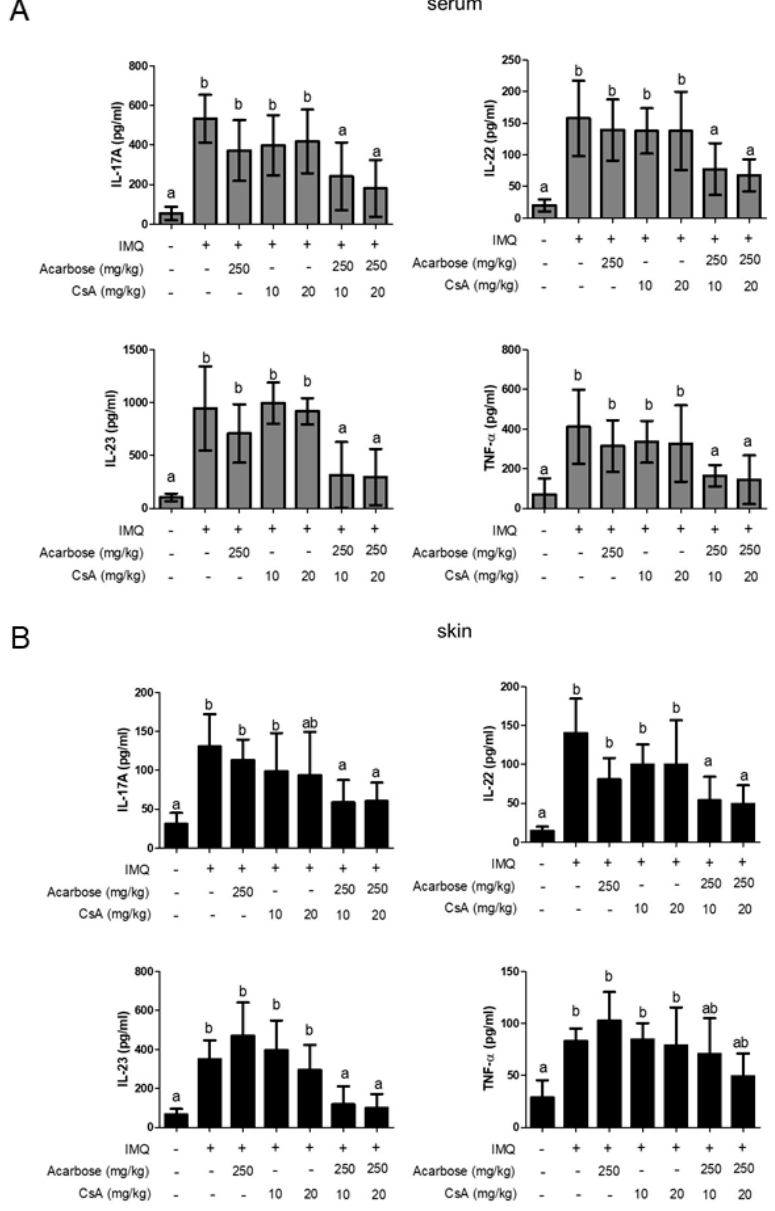
Figure 4. Effect of Acar (250 mg/kg) and/or low-dose CsA (10 or 20 mg/kg) on serum and skin cytokines in mice with IMQ-induced psoriasis-like dermatitis on a daily basis for 9 days. The levels of interleukin (IL)-17A, IL-22, IL-23, and tumor necrosis factor (TNF)- α in the serum ( A ) and skin ( B ) were measured using ELISA. IMQ-induced mice were randomly assigned to 6 groups ( n = 6): IMQ alone, Acar (250 mg/kg/day), CsA (10 mg/kg/day), CsA (20 mg/kg/day), Acar (250 mg/kg/day) + CsA (10 mg/kg/day), and Acar (250 mg/kg/day) + CsA (20 mg/kg/day). The mice were subjected to an intervention with either Acar or CsA alone or in combination per day for 9 consecutive days orally. Experimental data are expressed as the mean ± SD ( n = 6) and data analysis was performed with Mann–Whitney U test. Columns with different superscript letters (a, b, ab) are significantly different at p < 0.05.